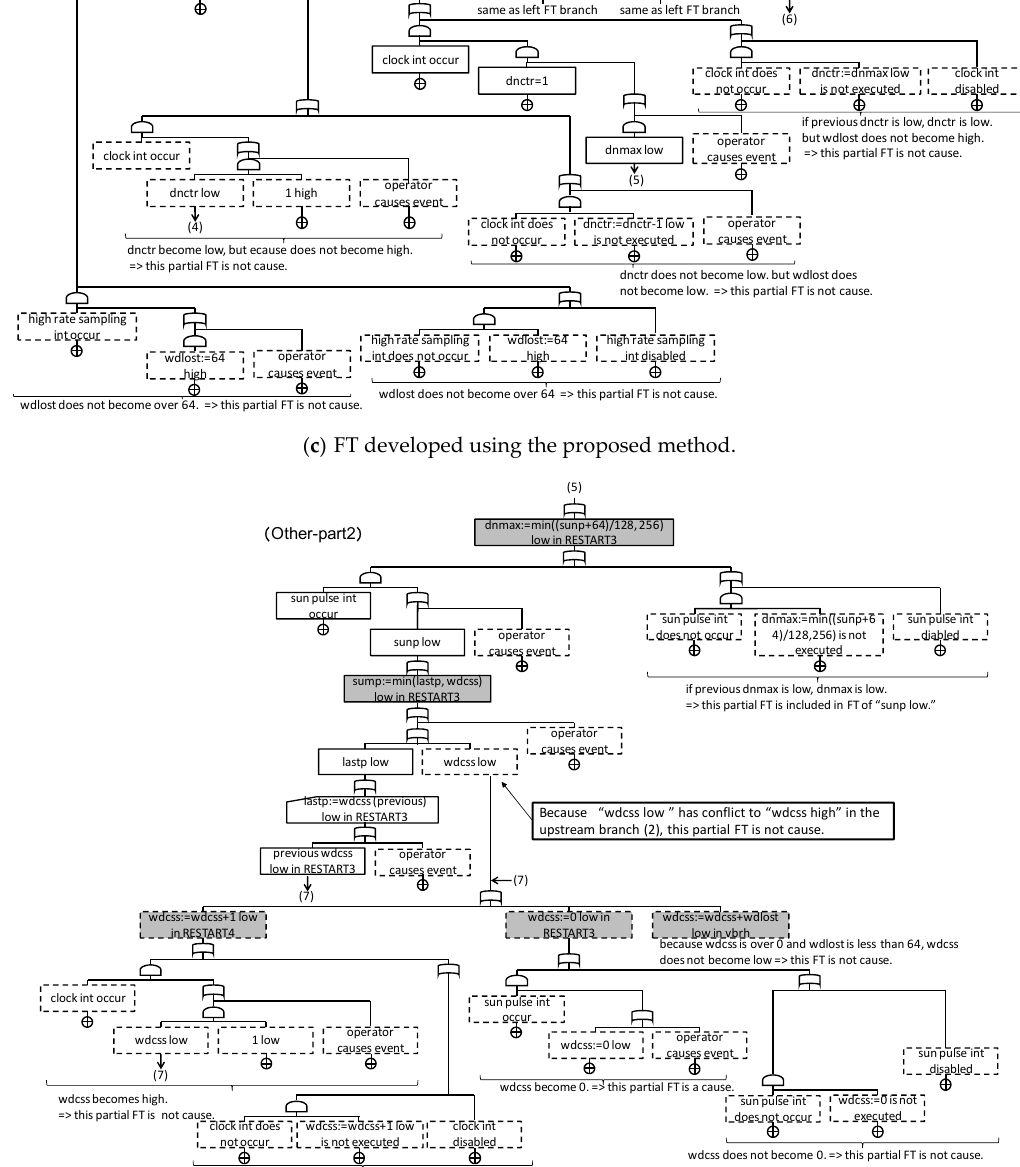
( d ) FT developed using the proposed method. Figure 18. FT developed using the proposed method. Figure 18. FT developed using the proposed